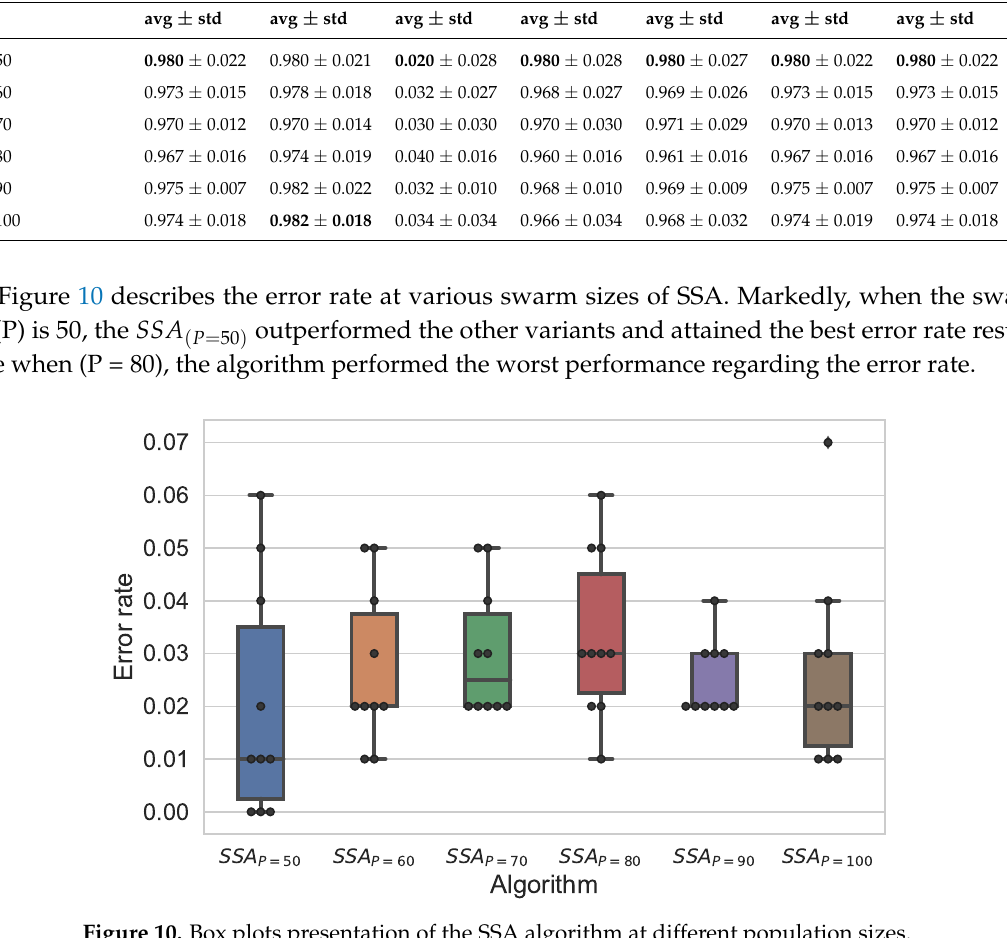
Figure 10. Box plots presentation of the SSA algorithm at different population